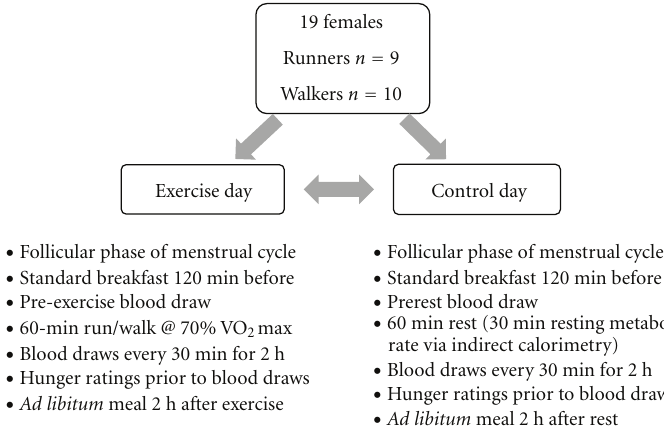
Figure 1: Schematic of the counter-balanced cross-over